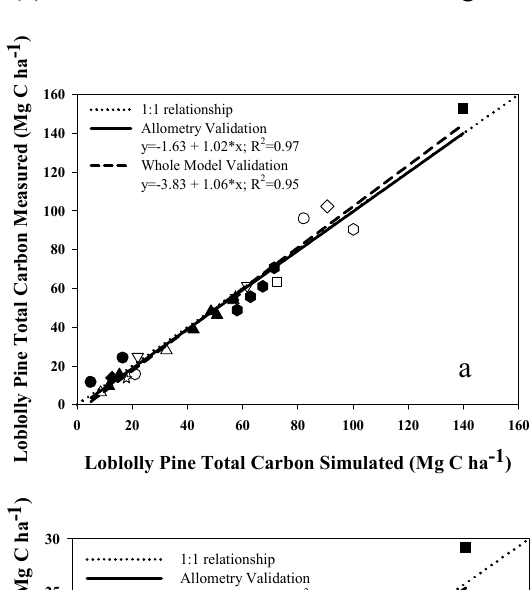
Figure 3. Validation of allometric equations (black filled symbols) and whole model (open symbols) outputs: ( a ) Simulated versus measured total C stock (T ( b ) Simulated versus measured aboveground (AG ( c ) Simulated versus measured belowground (BG